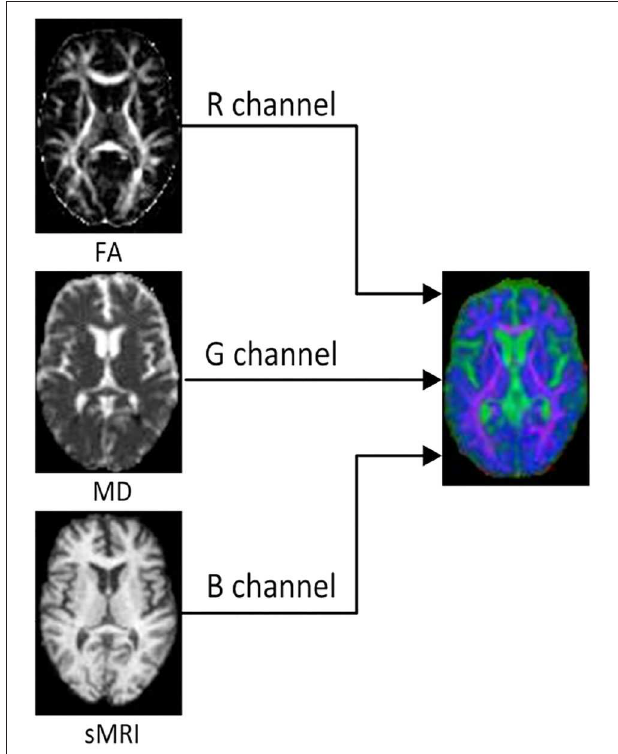
FIGURE 1 | The FA, MD, and sMRI slice with the same index on the left are merged into an RGB slice on the right.